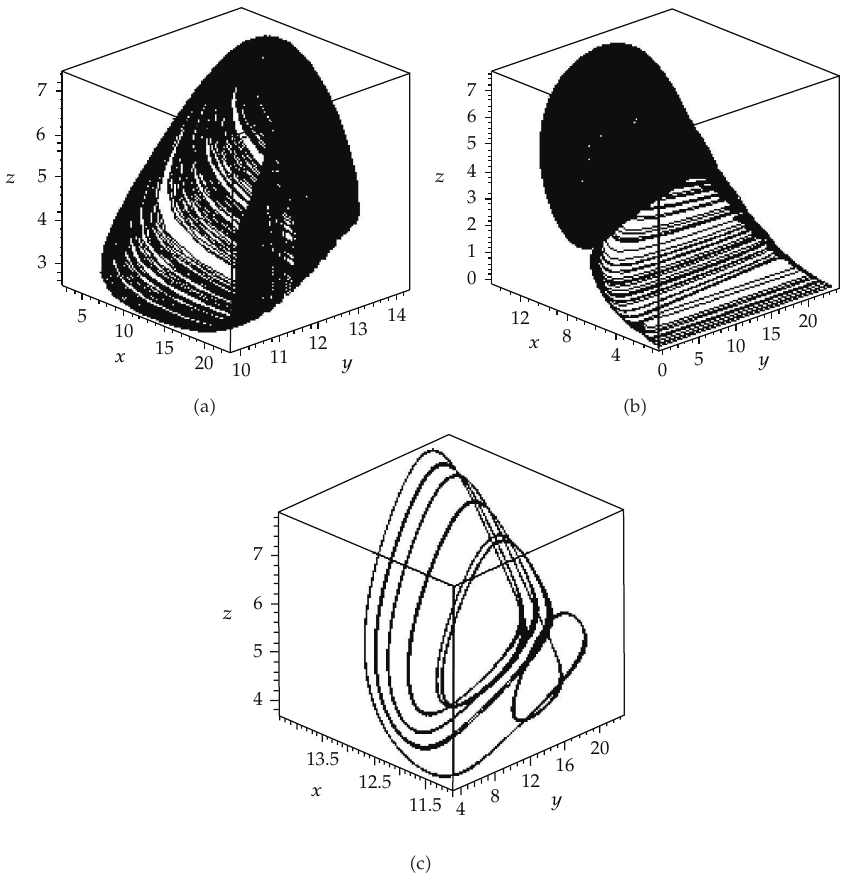
Figure 2: (cid:7) a (cid:8) Chaos when k 2 (cid:6) 24, ϕ (cid:6) 0; (cid:7) b (cid:8) chaos when k 2 (cid:6) 24, ϕ (cid:6) (cid:7) π/ 2 (cid:8) ; (cid:7) c (cid:8) periodic attractor when k (cid:6) 24, ϕ (cid:6) π 2